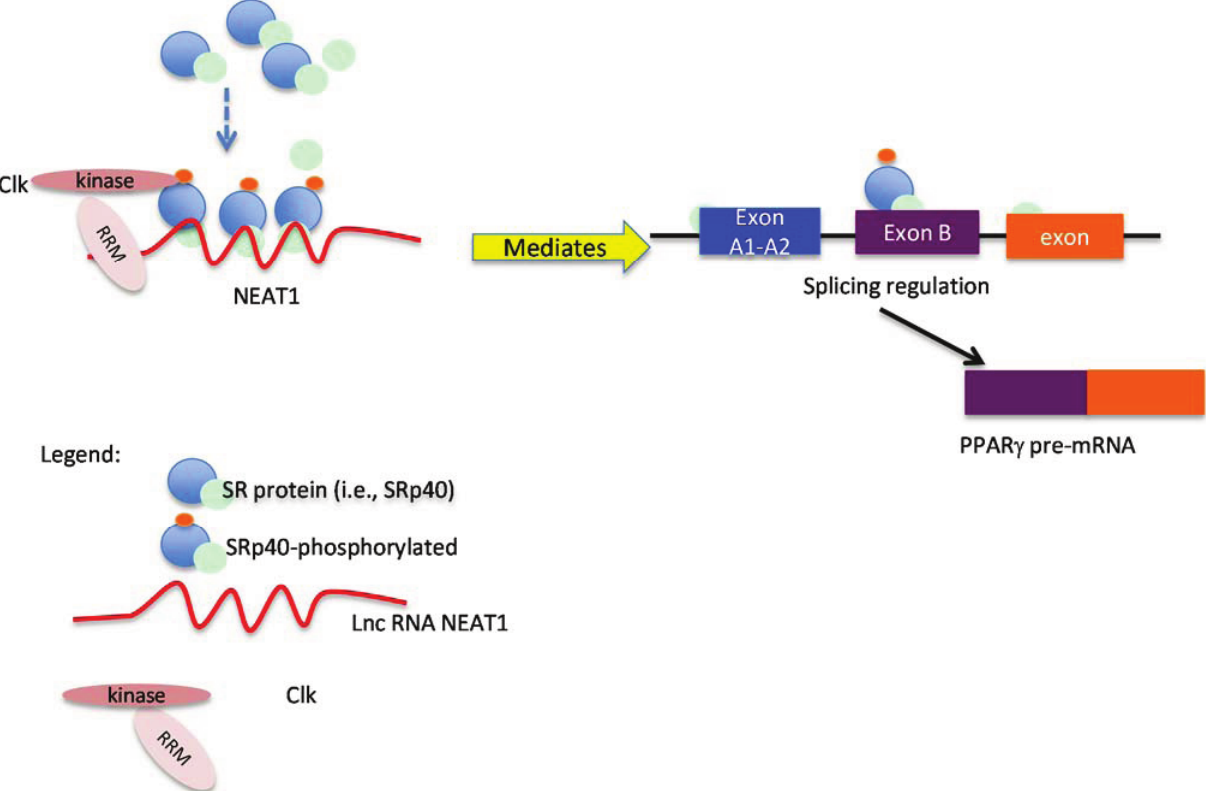
Figure 5. NEAT1 associates with SRp40 to potentiate its phosphorylation by Clk kinase (presumably in paranuclear bodies). This schematic shows how NEAT1 can tether SR proteins and, specifically, SRp40, and Clk kinase prior to its release and role in PPAR(cid:2) splicing